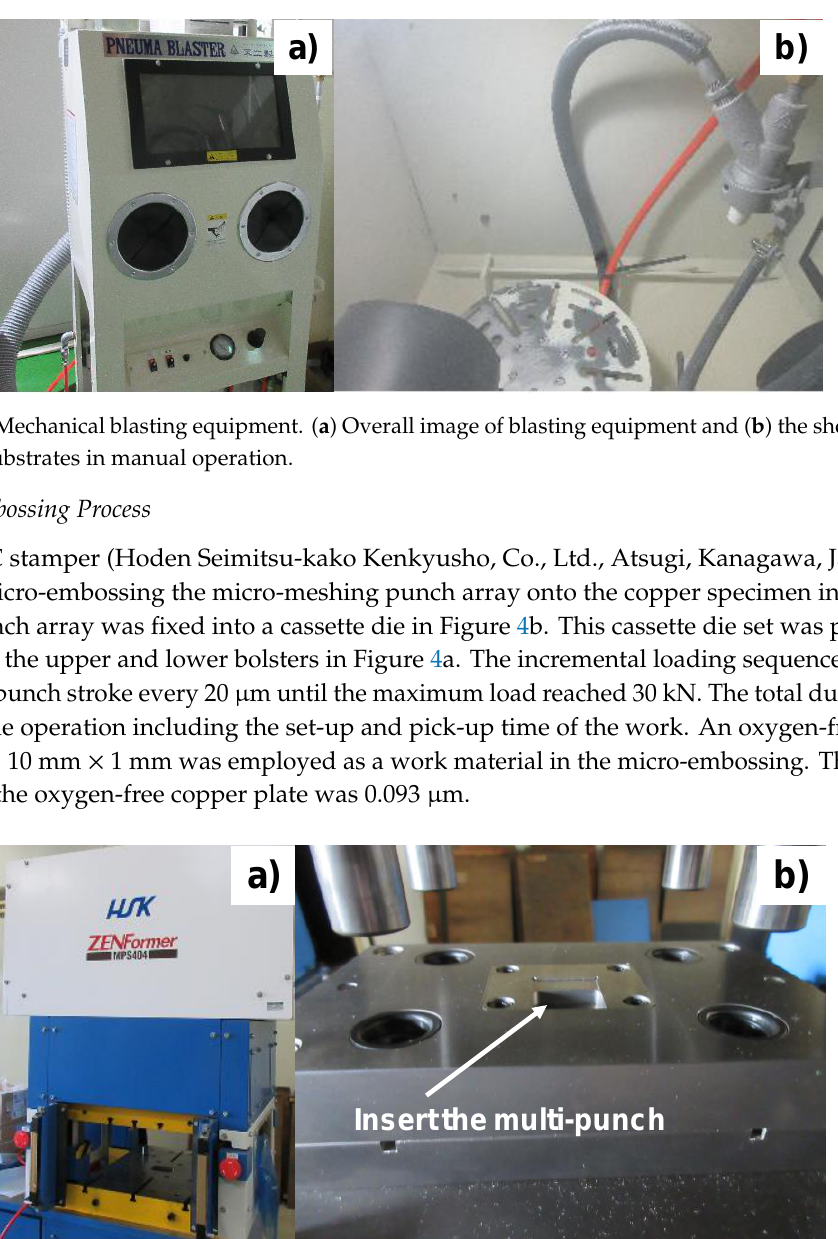
Figure 4. CNC-controlled stamper for micro-embossing onto the copper plates. ( a ) Overview of the CNC-stamper and ( b ) the cassette die set.